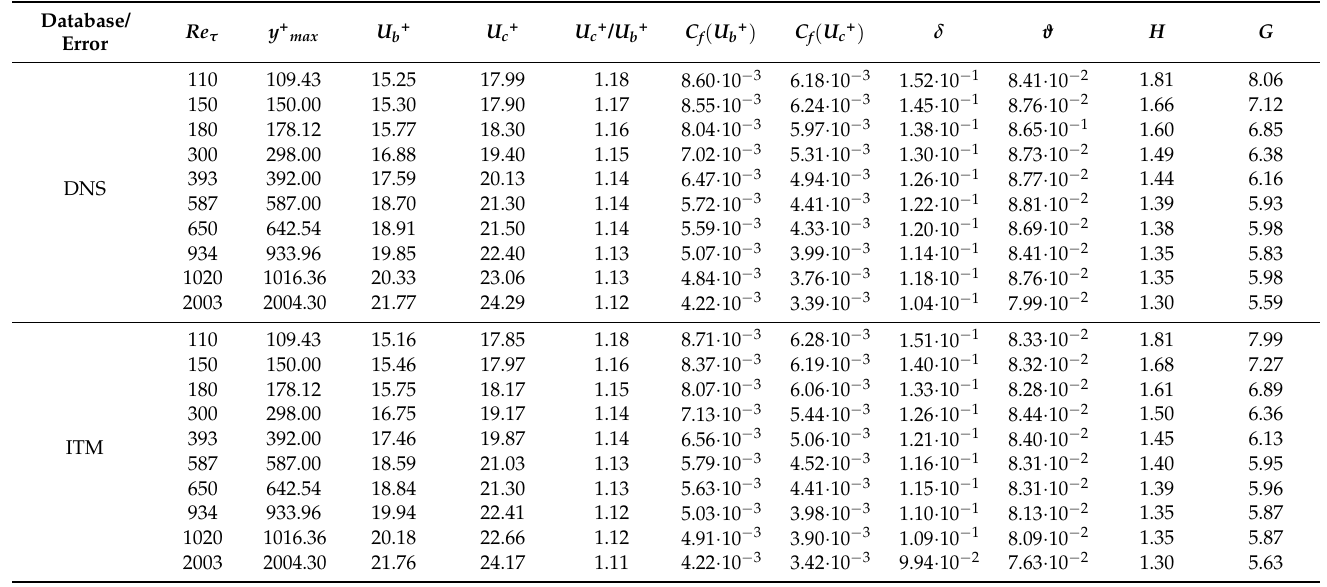
2000 Figure 6. Trend of the first shape factor H = δ / ϑ and of the second shape factor G = U c + (( H − 1 ) / H ) ; and of the second shape factor Figure 6. Trend of the first shape factor • DNS data; and – ITM. ; • DNS data; and ─ ITM. 𝐻𝐻 = 𝛿𝛿 𝜗𝜗⁄ 𝑐𝑐+ (( 𝐻𝐻 − 1) 𝐻𝐻⁄ ) 𝑈𝑈 Table 2. Mean flow properties extracted from DNS databases and from ITM. The parameters are (cid:0) (cid:1) U b + defined as: U b + is the mean velocity; U c + the centerline velocity; C f the skin friction based (cid:0) (cid:1) = (cid:0) (cid:1) U b + U c + on the mean velocity C f 2/ U b + 2 ; C f the skin friction based on the centerline velocity (cid:16) (cid:17) (cid:82) 1 (cid:0) (cid:1) = C f U c + 2/ U c + 2 ; δ the displacement thickness δ = 1 − u + d ζ , where ζ = y + / y + max ; ϑ the U c + 0 (cid:16) (cid:17) (cid:82) 1 u + momentum thickness ϑ = 1 − u + d ζ ; H the first shape factor H = δ / ϑ ; and G the U c + U c + 0